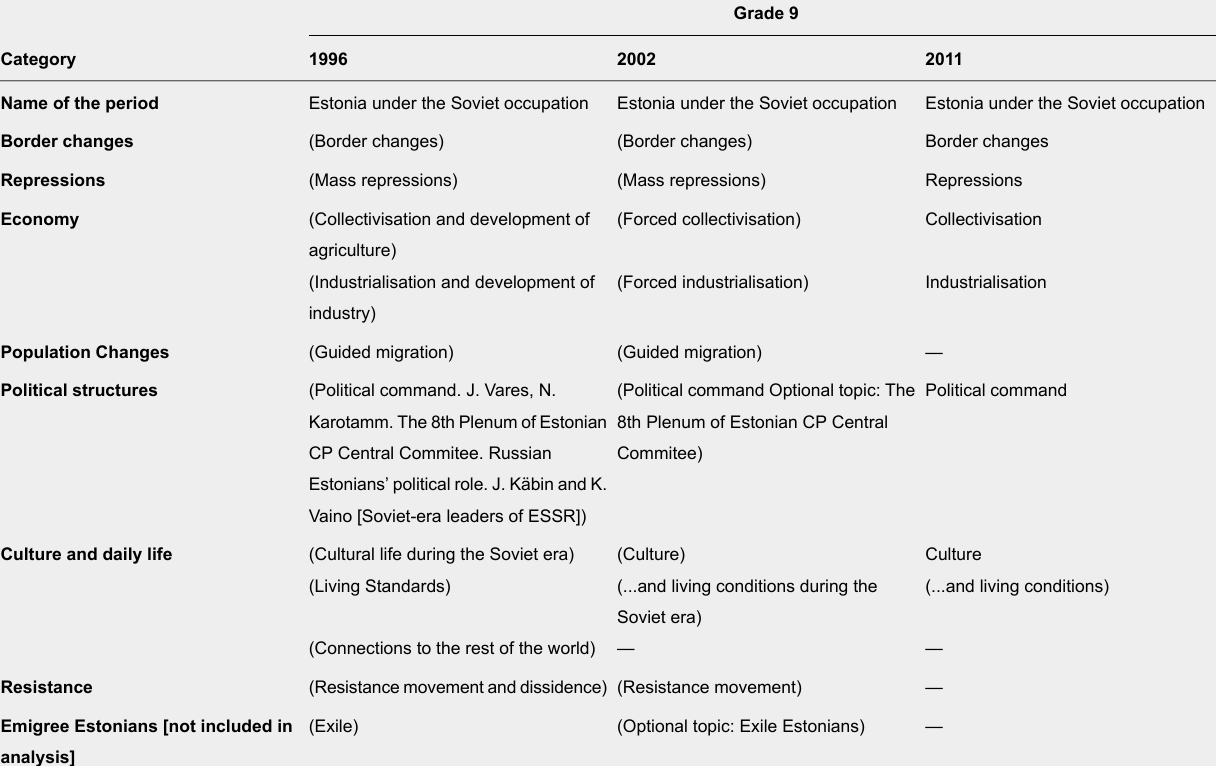
Keywords Related to the Post-WW2 Soviet-Era (From 1945 to 1985) in Estonia or Baltic Countries Present in the Estonian National Curricula and Commentaries That Accompany the Respective